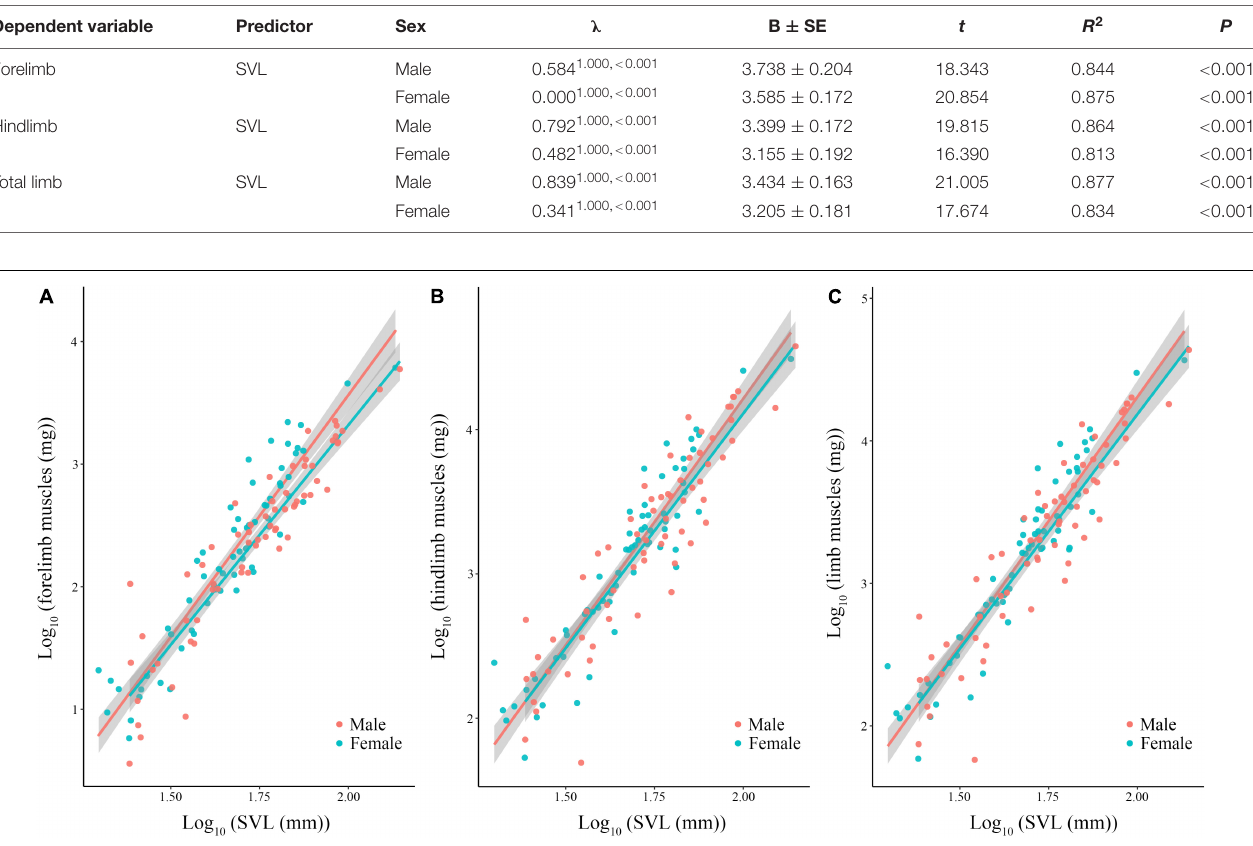
FIGURE 1 | Limb muscle mass [forelimb (A) , hindlimb (B) , and total limb (C) ] regressed on body size (SVL) among species of anurans. Each dot is a